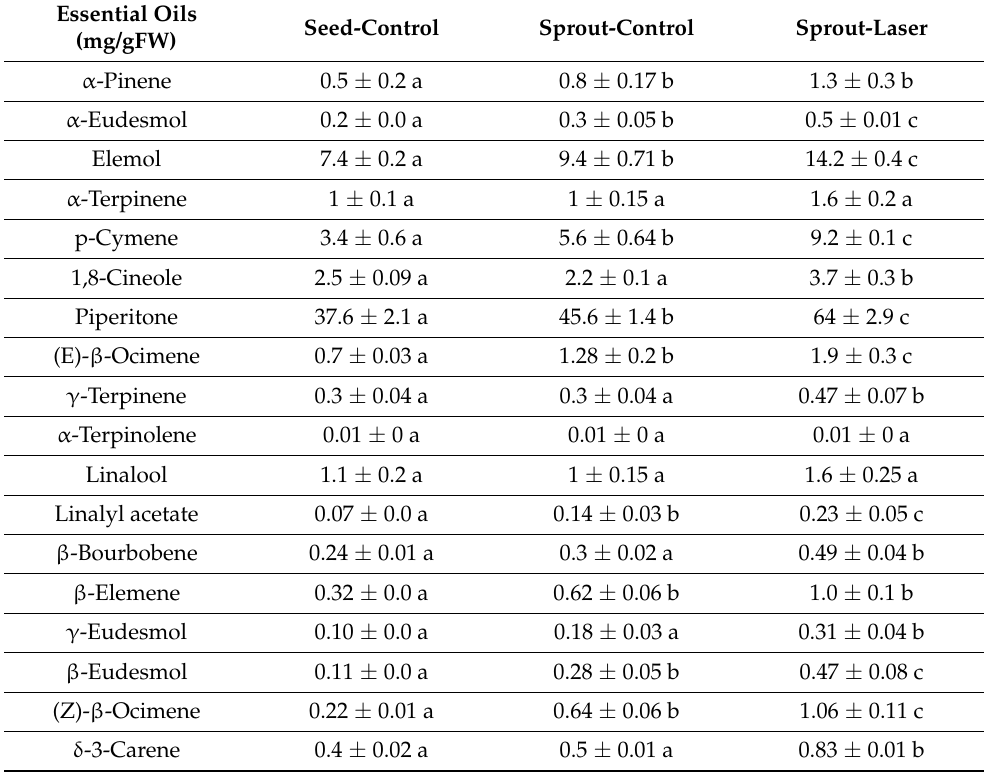
Table 4. Effect of He-Ne laser light treatment on essential oil contents of Cymbopogon proximus sprouts and seeds. Data are represented by means ± standard